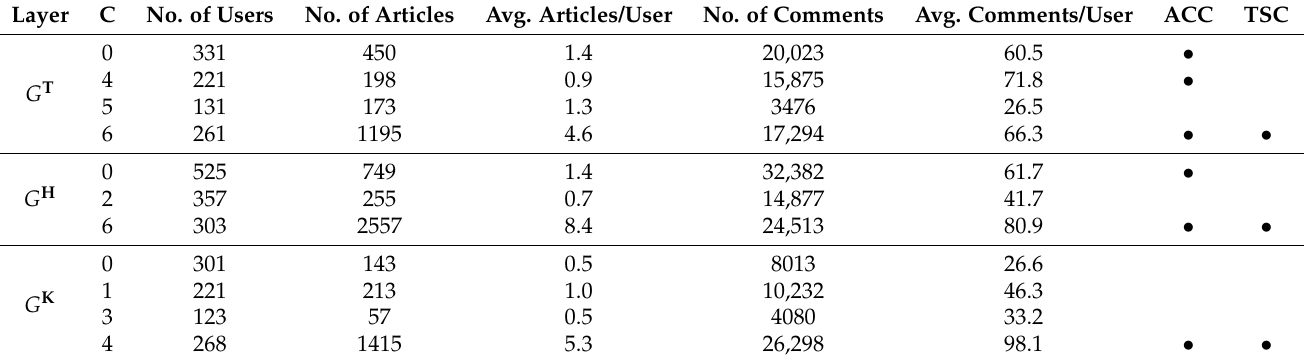
Table 6. ACCs and TSCs of the